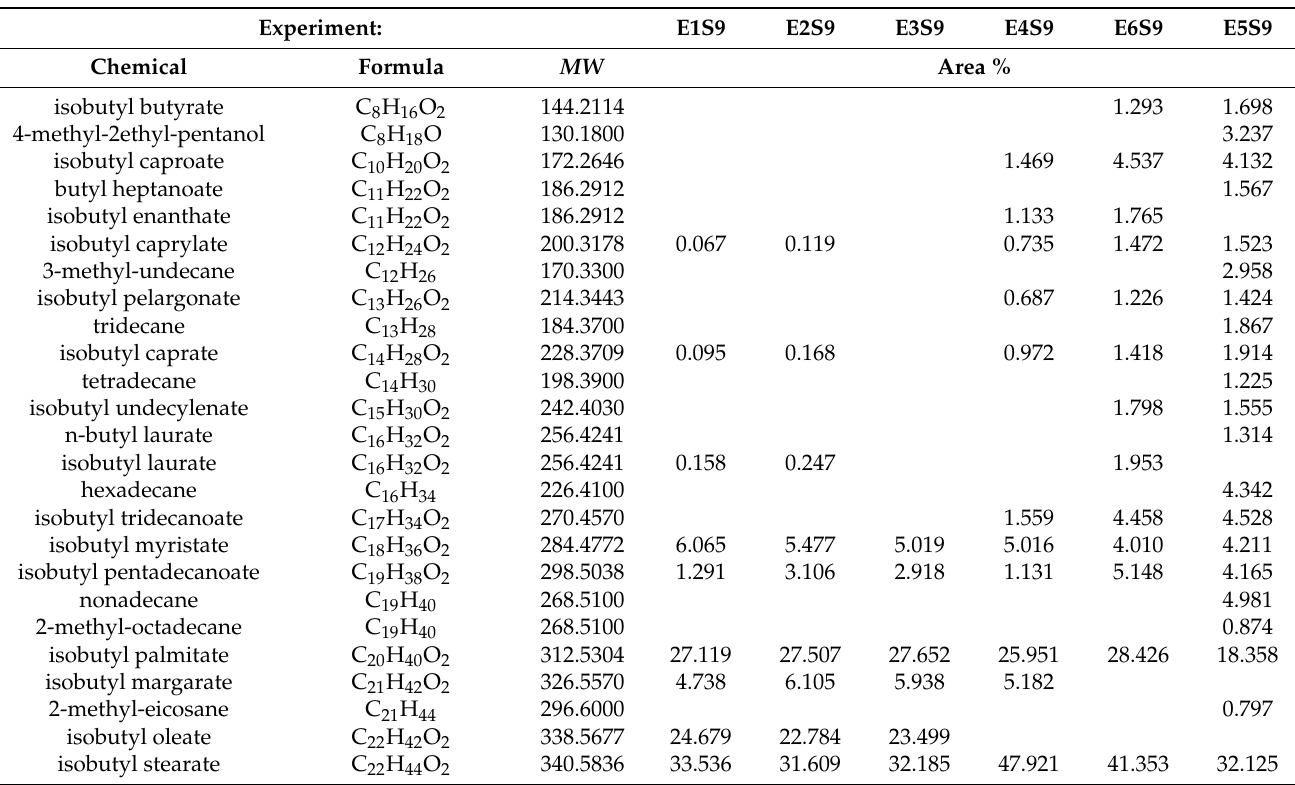
Table 4. FABE profile from beef tallow transesterification using iso-butanol.